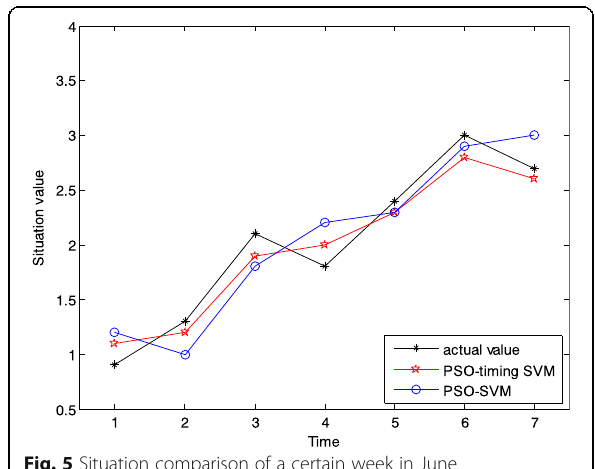
Fig. 5 Situation comparison of a certain week in June